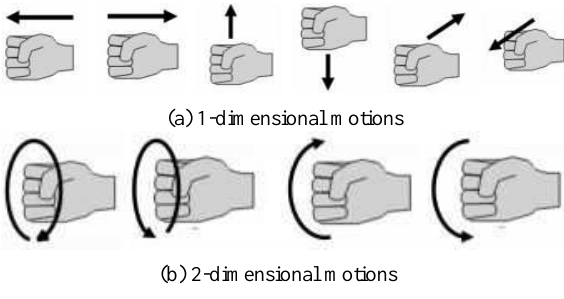
Fig. 8. Command gestures using hand